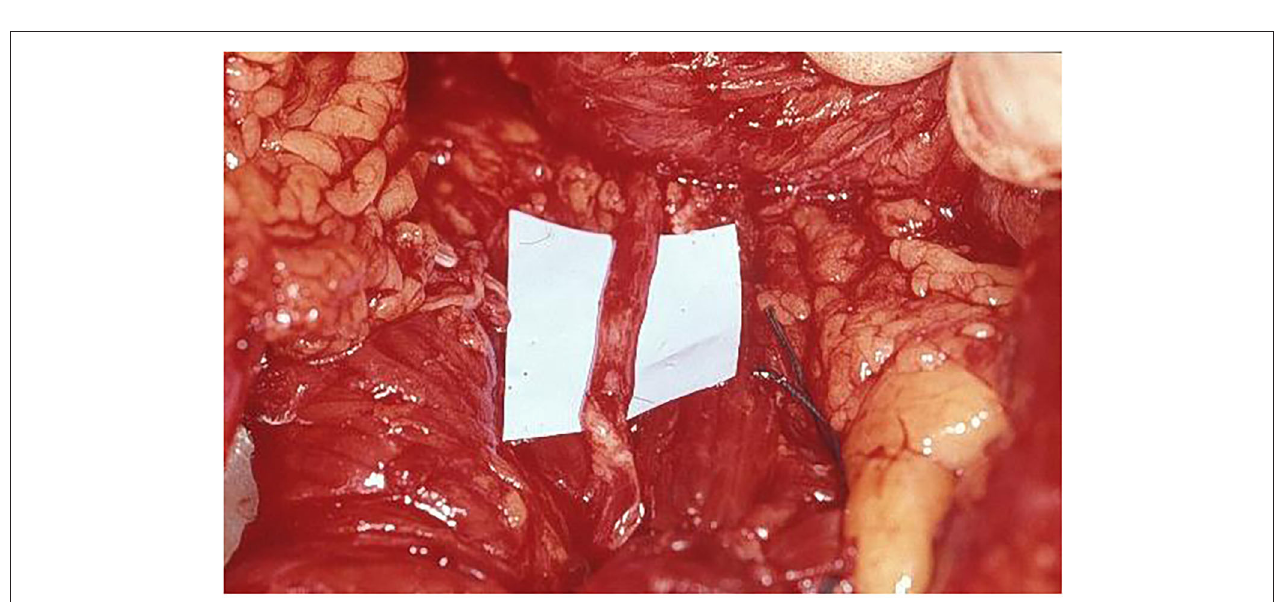
FIGURE 6 | Nerve coaptation, with excellent nerve matching, between thoracodorsal nerve and motor branch of intercostal nerve supplying rectus abdominis muscle.